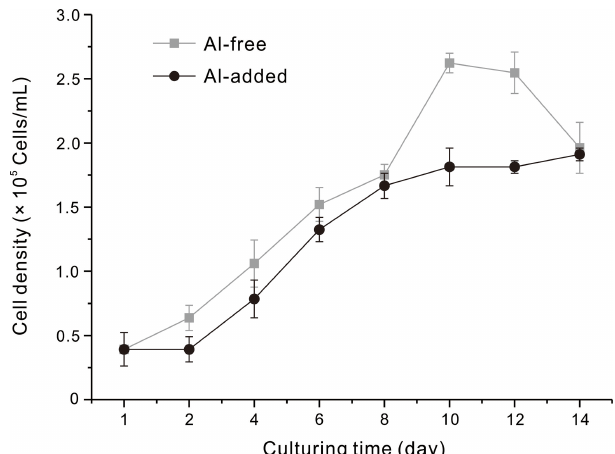
tios were obtained at a voltage of 15 kV and a current of 20 µA. Carbon coating was performed before the SEM-EDS analysis.